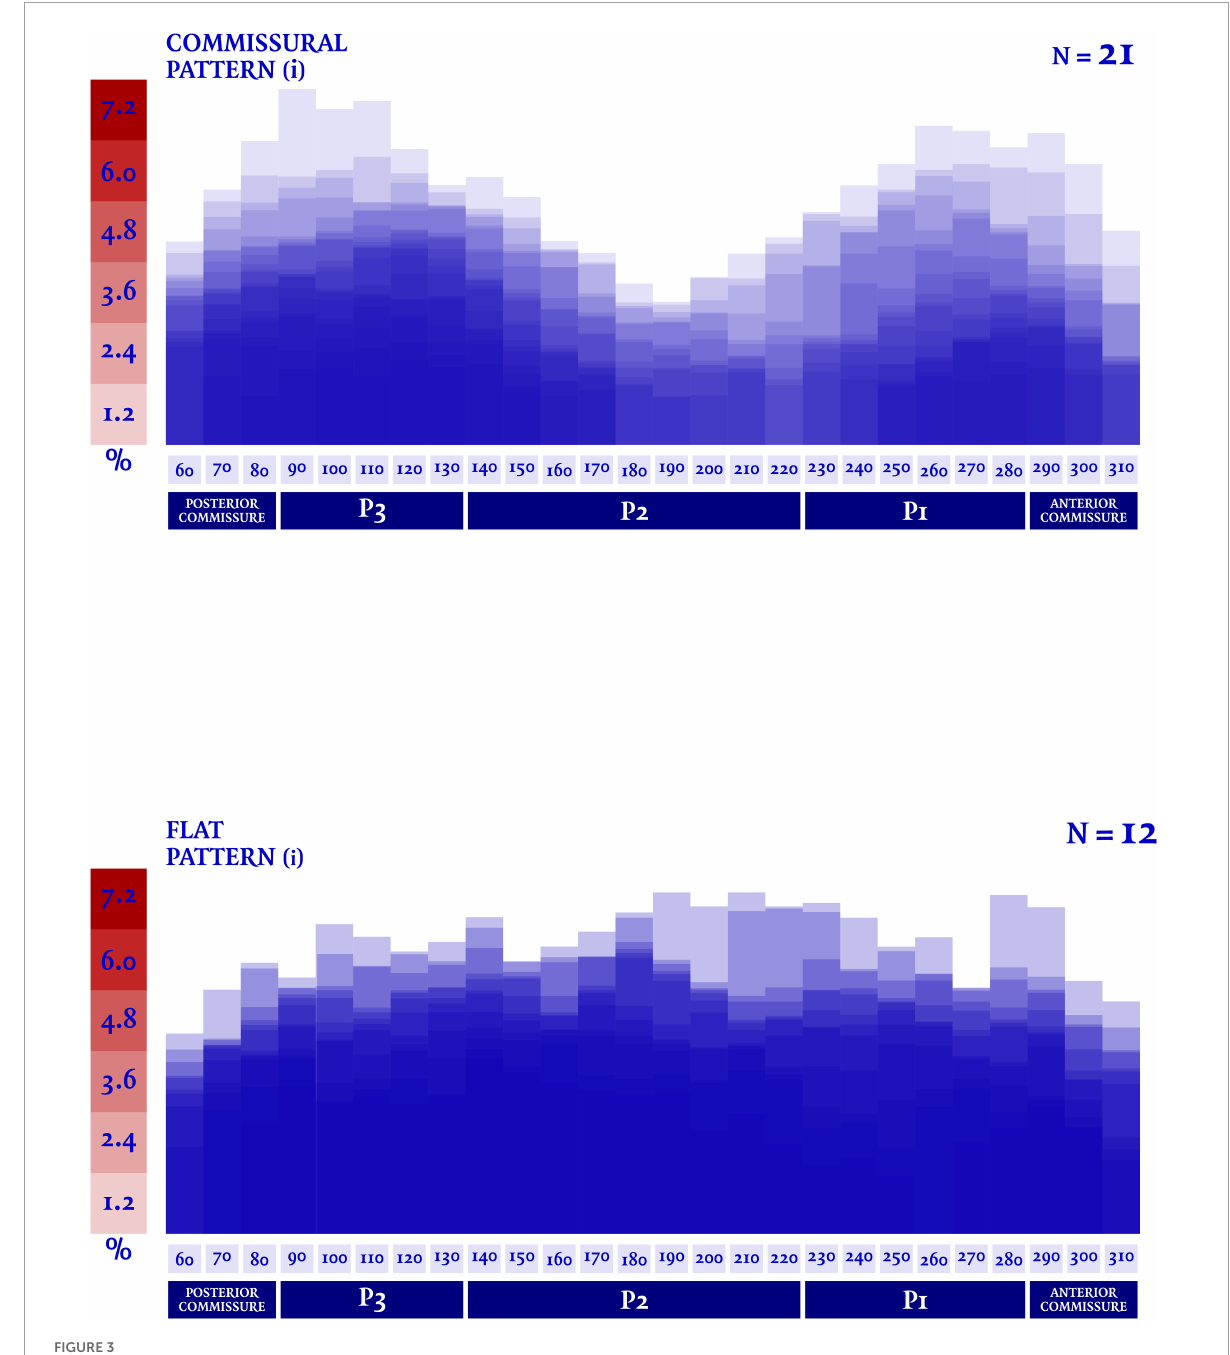
FIGURE3 A dedicated quantification software (Mitral Valve Navigator, Philips Healthcare) was used for the rendering analysis of the valvular geometry. The circumferential values of disjunction distance (DD) were then singularly indexed to the total mitral circumference, in order to express the disjunction distance as a percentage of the total circumferential length of the